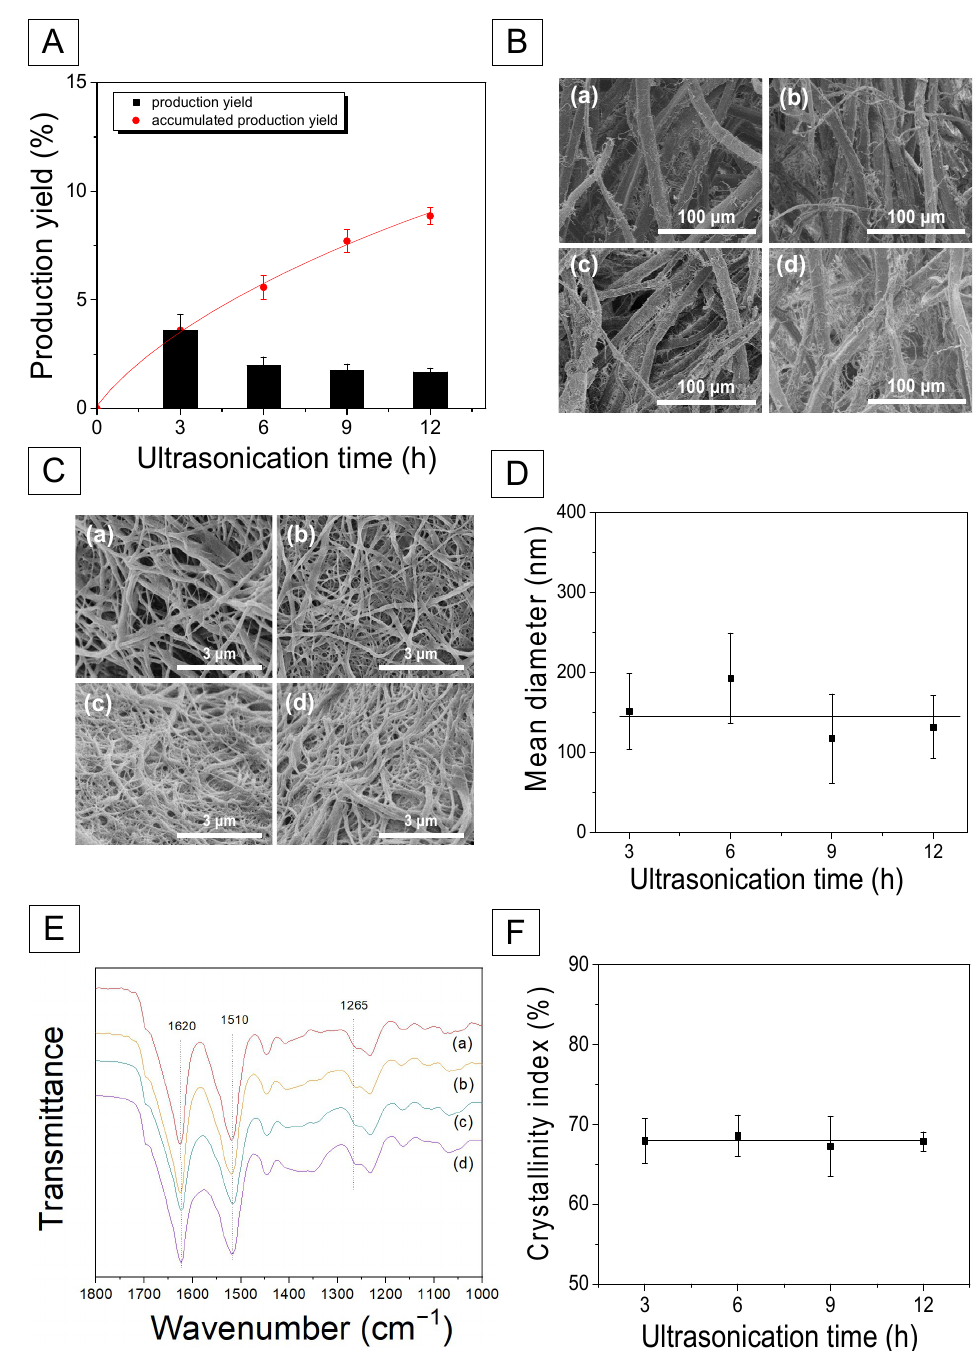
Figure 2. ( A ) Production yields of silk nanofibril, ( B ) FE-SEM images of the degummed and ultrasonicated silk fibers, ( C ) FE-SEM images of the silk nanofibrils, ( D ) Mean diameter of the silk nanofibrils, ( E ) FTIR spectra, and ( F ) crystallinity index of the silk nanofibrils produced at various ultrasonication times; ( a ) 3 h, ( b ) 6 h, ( c ) 9 h, and ( d ) 12 h.